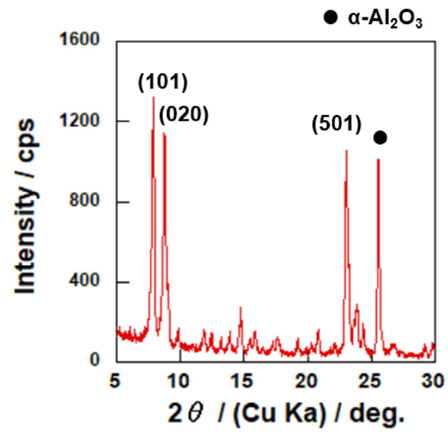
Figure 4. XRD pattern of prepared membrane.